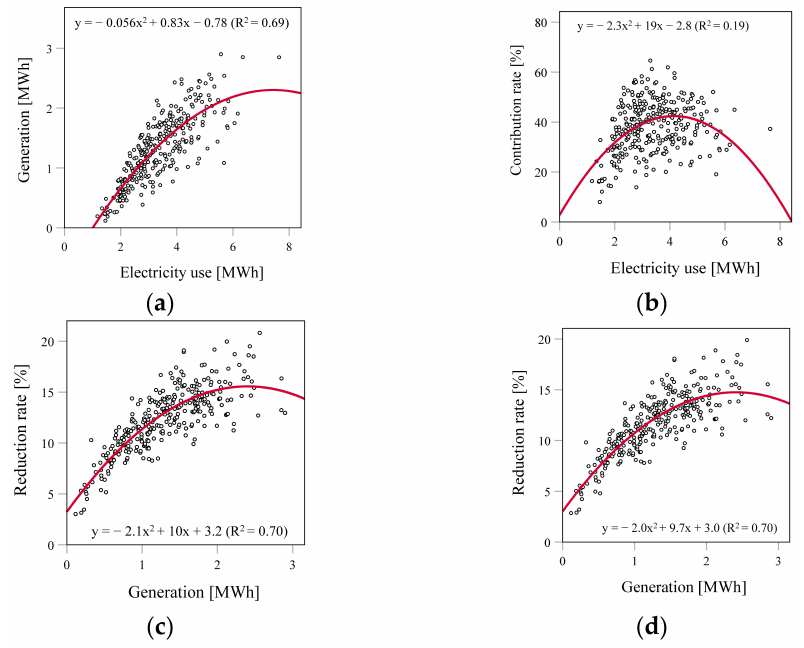
Figure 4. Relationship of annual values in each household (n = 304): ( a ) generation and electricity use; ( b ) contribution rate and electricity use; ( c ) reduction in primary energy and generation; ( d ) reduction in CO 2 emission and